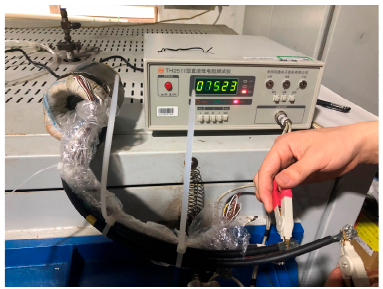
Figure 6. Photo of motor DC resistance test.